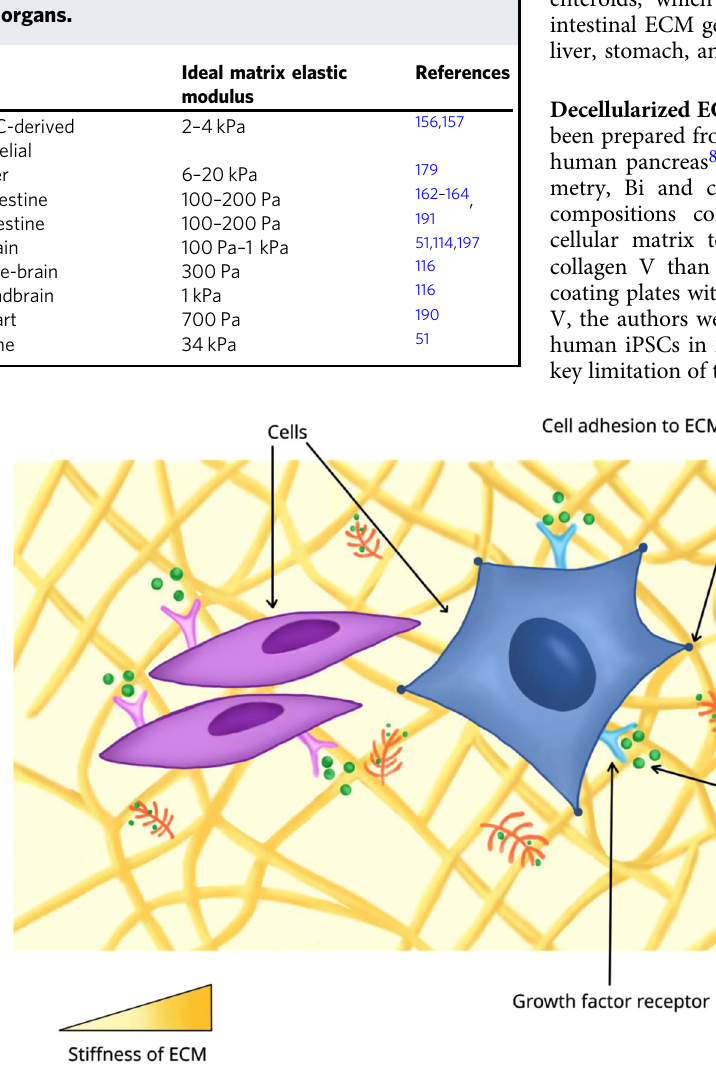
Fig. 2 Microenvironment of cells. Cells in an organ or organoid are surrounded by other cells, extracellular matrix (ECM) proteins, and growth factors sequestered in the proteoglycan-modi fi ed ECM proteins. Cells bind to ECM proteins via adhesion molecules, such as integrin receptors, which provide signaling cues to exert biological functions. The stiffness of ECM experienced by the cells also affects their biological